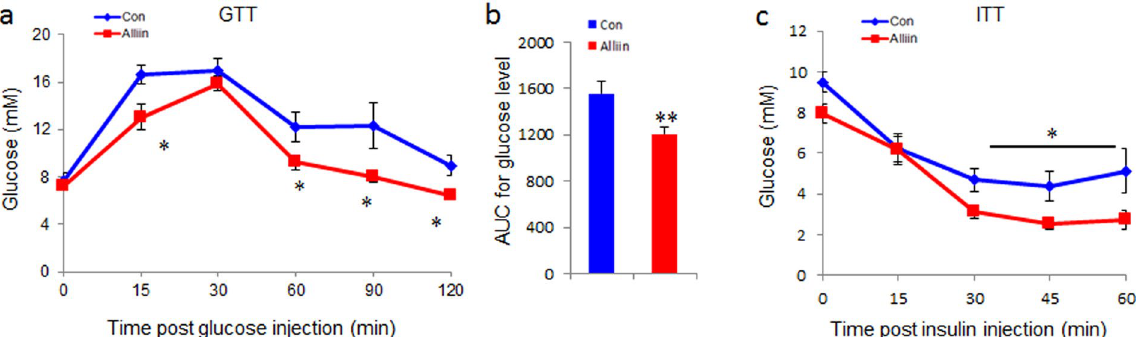
Figure 1. Alliin improves glucose tolerance and insulin sensitivity in DIO mice. ( a and b ) Alliin significantly reduced glucose level challenged with insulin in DIO mice. ( c ) Alliin significantly improved insulin sensitivity to glucose injection in DIO mice. Data are means ± SEM (n = 10). * P < 0.05, ** P < 0.01. GTT, glucose tolerance test; ITT, insulin tolerance test.